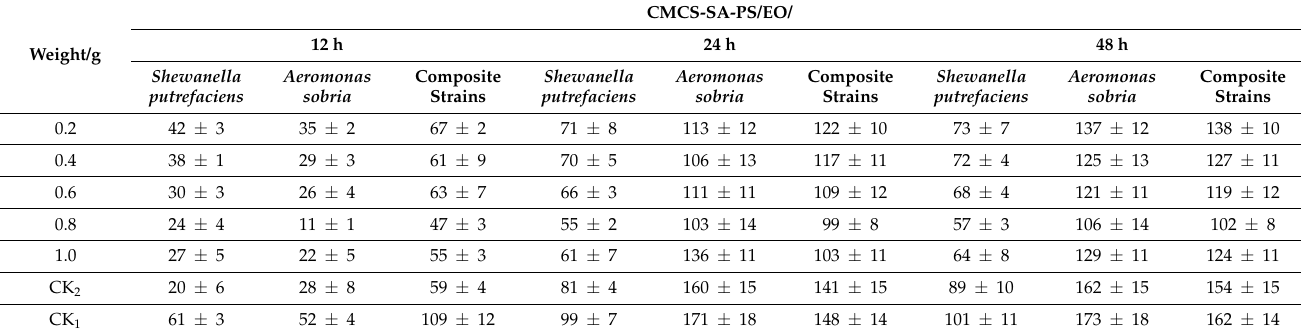
Table 5. Bacterial colony count for microencapsulation inhibition